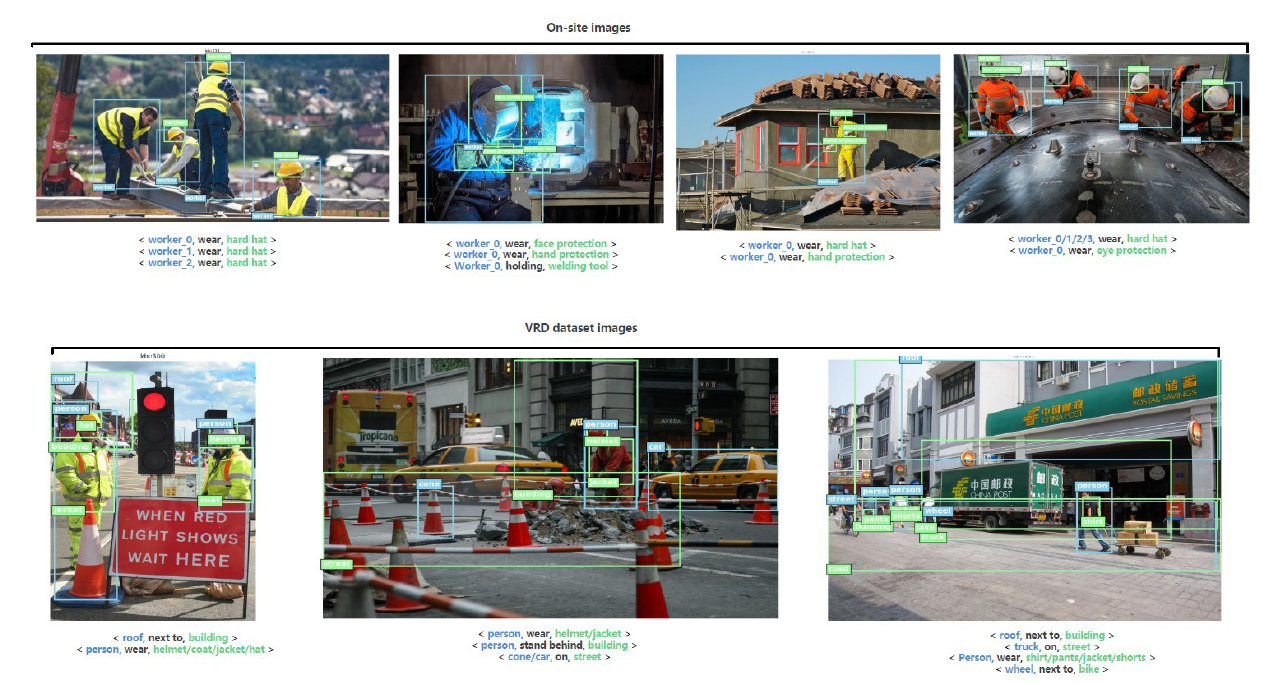
Figure 7. Qualitative examples of scene graph generation on self-built and VRD datasets.